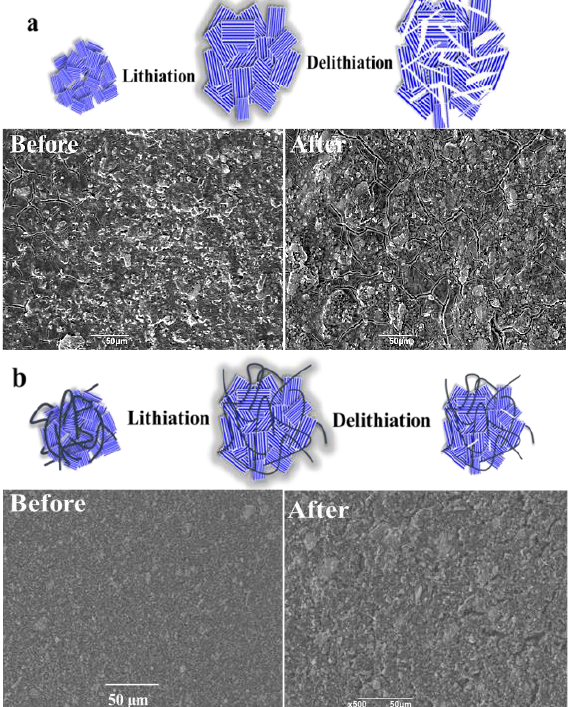
Figure 9. Schematic diagram of surface structure changes of lithiation and delithiation reaction and SEM images of B-AsP ( a ) and GO/B-AsP/CNTs ( b ) electrodes before and after 50 cycles.